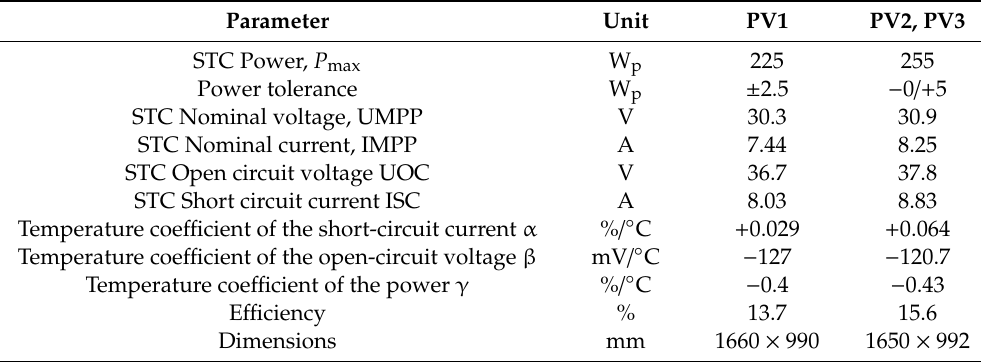
Table 1. Parameters of the photovoltaic panels used in the laboratory